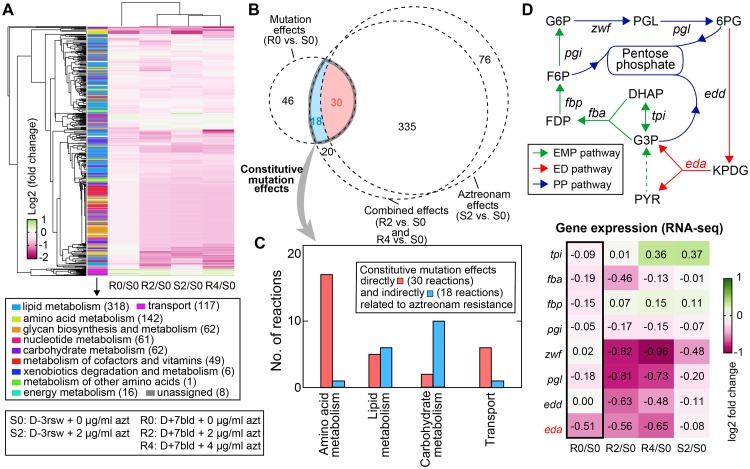
Evolved metabolic-level adaptations in the aztreonam-resistant strain.(A) Metabolic flux changes relative to the reference condition S0 (D-3rsw, no aztreonam). (B) Venn diagram showing the overlap between reactions whose flux levels significantly altered by aztreonam alone, mutations alone, and their combination. Among all 48 reactions constitutively modulated by mutations (i.e., constitutive mutation effects), 30 are directly related to aztreonam resistance (because aztreonam can induce their responses) and 18 are indirectly related. (C) Grouping of the 48 constitutively modulated reactions by pathways they belong to. (D) Expression of eda serves as a bottleneck to the flux through the Entner-Doudoroff (ED) pathway (red arrows). The connected Embden-Meyerhof-Parnas (EMP) pathway (green arrows) and pentose phosphate (PP) pathway (blue arrows), as well as the relative expression changes of the major genes in the three pathways (heatmap) are also shown. Tpi: triose phosphate isomerase; fba: fructose-1,6-biphosphate aldolase; fbp: fructose-1,6-biphosphatase; pgi: glucose-6-phosphaate isomerase; zwf: glucose-6-phosphate dehydrogenase; pgl: 6-phosphogluconolactonase; edd: phosphogluconate dehydratase; eda: 2-dehydro-3-deoxy-phosphogluconate aldolase; DHAP: dihydroxyacetone phosphate: FDP: D-fructose-1,6-biphosphate; F6P: fructose-6-phosphate; G6P: glucose-6-phosphate; PGL: 6-phospho-D-glucono-1,5-lactone; 6PG: 6-phospho-D-gluconate; KPDG: 2-dehydro-3-deoxy-6-phospho-D-gluconate; G3P: glyceraldehyde 3-phosphate; PYR: pyruvate.